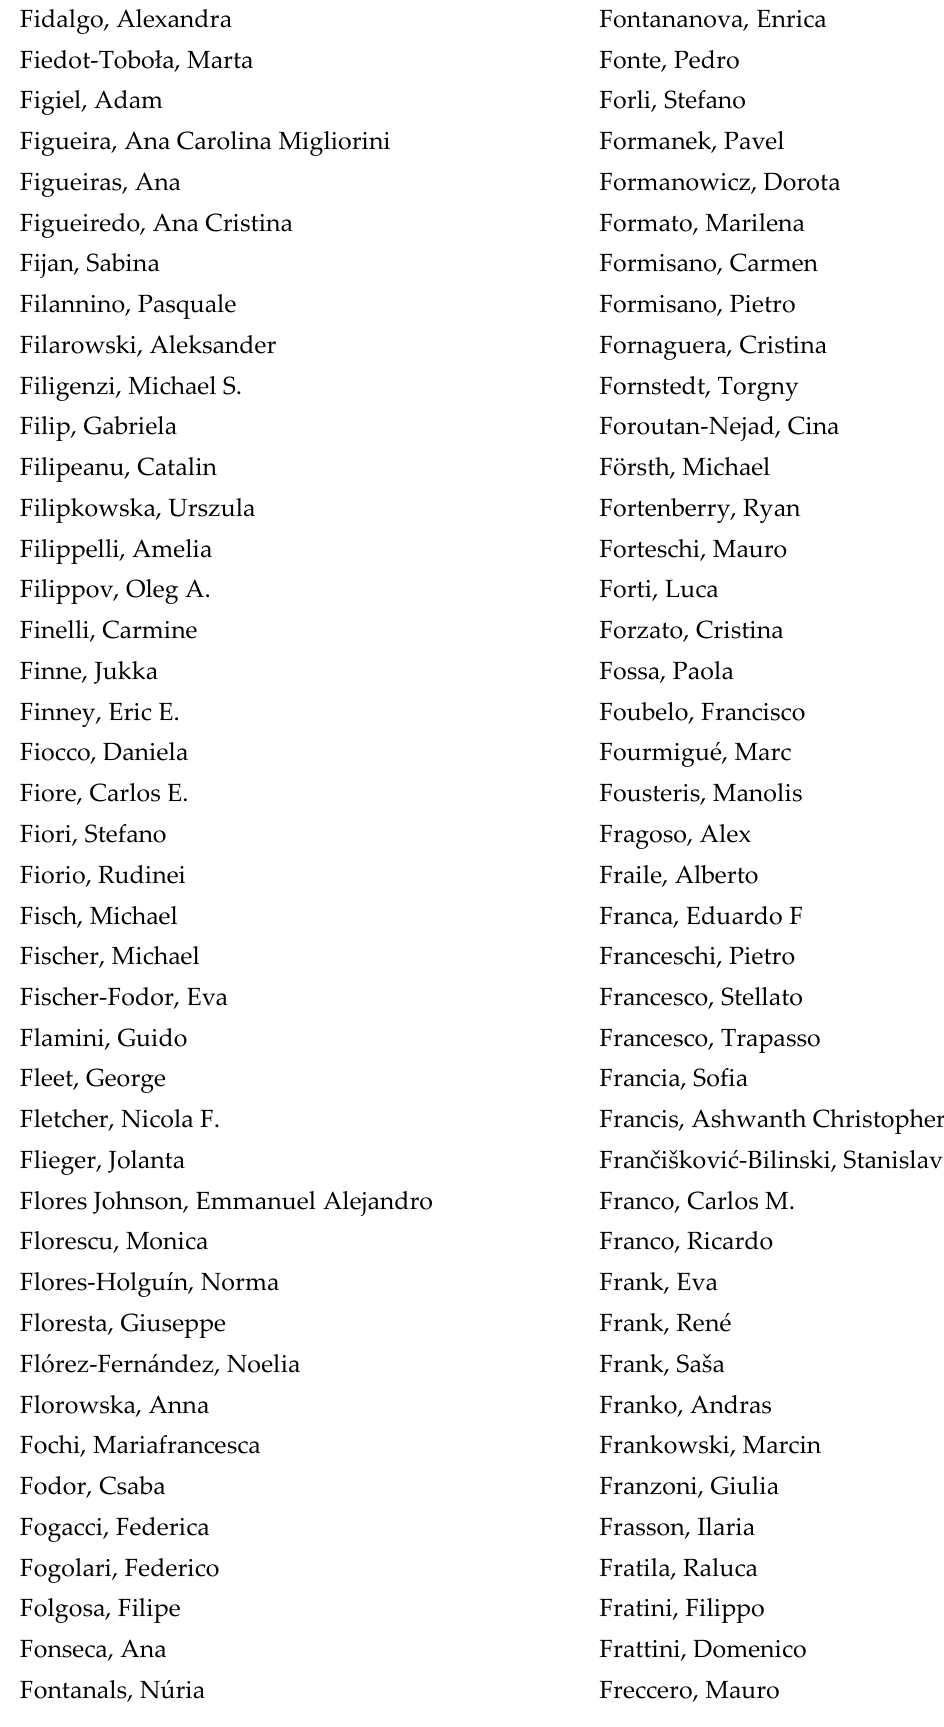
Figiel, Adam Figueira, Ana Carolina Migliorini Figueiras, Ana Figueiredo, Ana